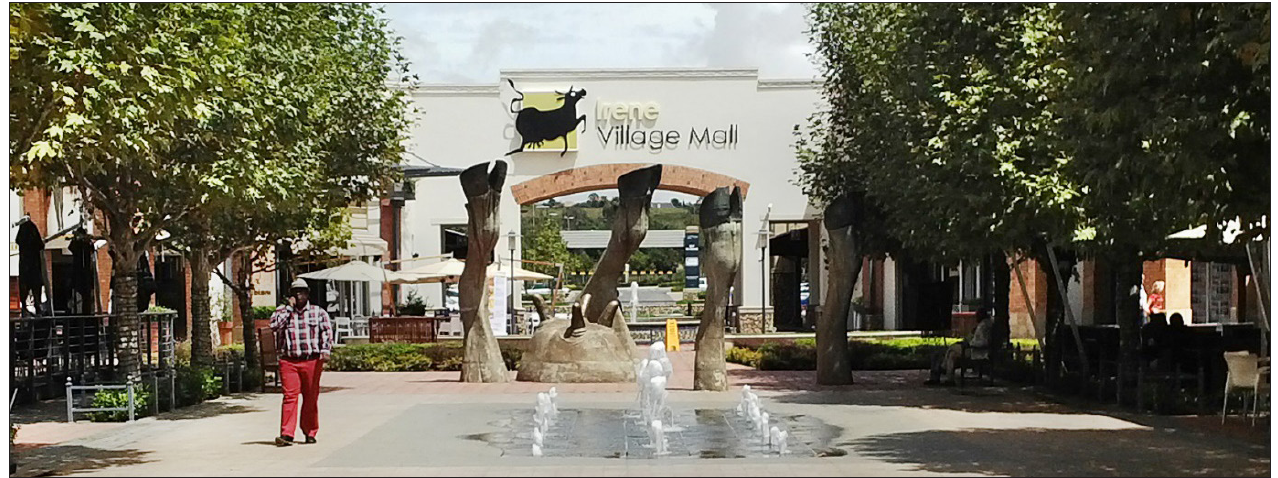
Figure 5: The main gathering space in the Irene Village Mall with the gateway in the background Source: